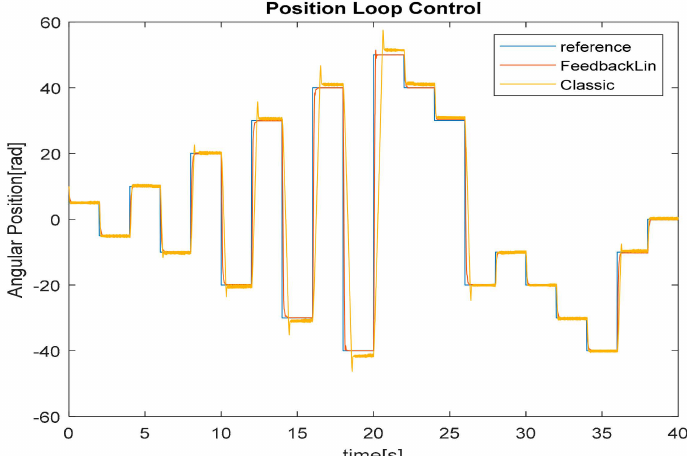
Figure 9. Comparison of the result of the control with reduction of the cogging by feedback linearization vs. a classical cascade control structure